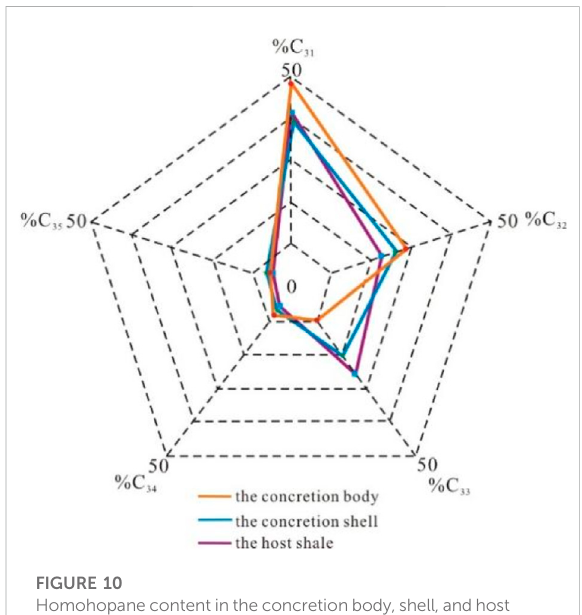
FIGURE 10 Homohopanecontentintheconcretionbody,shell,andhost